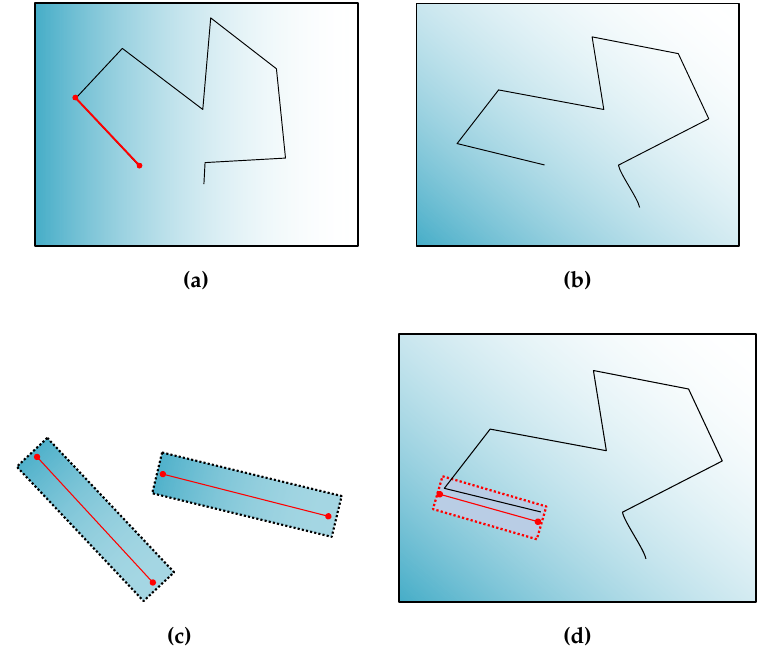
Figure 8. Line matching process. ( a ) Frame captured at camera pose C 0 , where line x was initialized; ( b ) frame captured at camera pose C i , where line x is intended to be matched; ( c ) patch warping process, showing the original and the transformed patches; ( d ) projection of landmark line x into image segment s i on the image at camera pose C i . The search area is indicated by the rectangle surrounding the